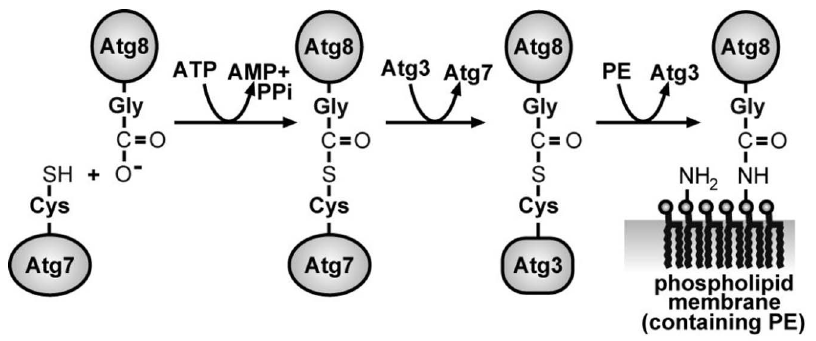
Fig. 1. Minimal system to covalently bind the protein Atg8 via an ubiquitin-like reaction to phosphatidylethanolamine (PE).